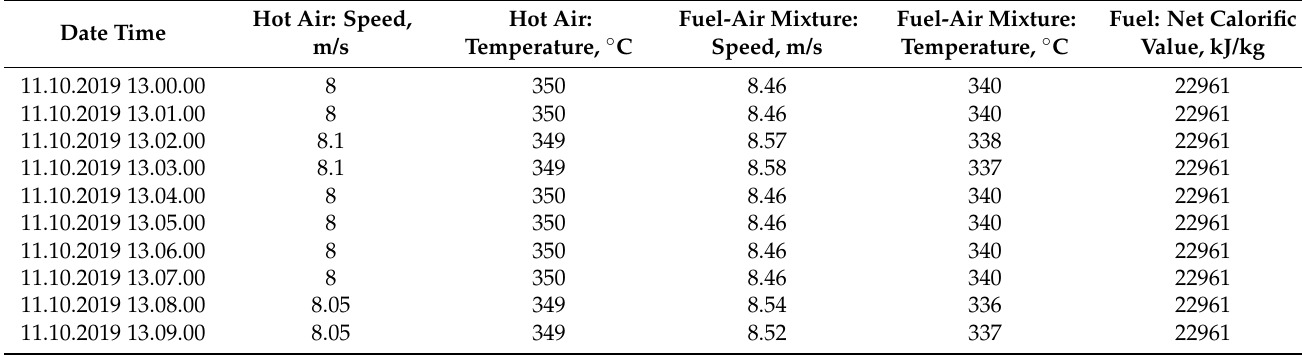
Table 1. Database appearance (Part